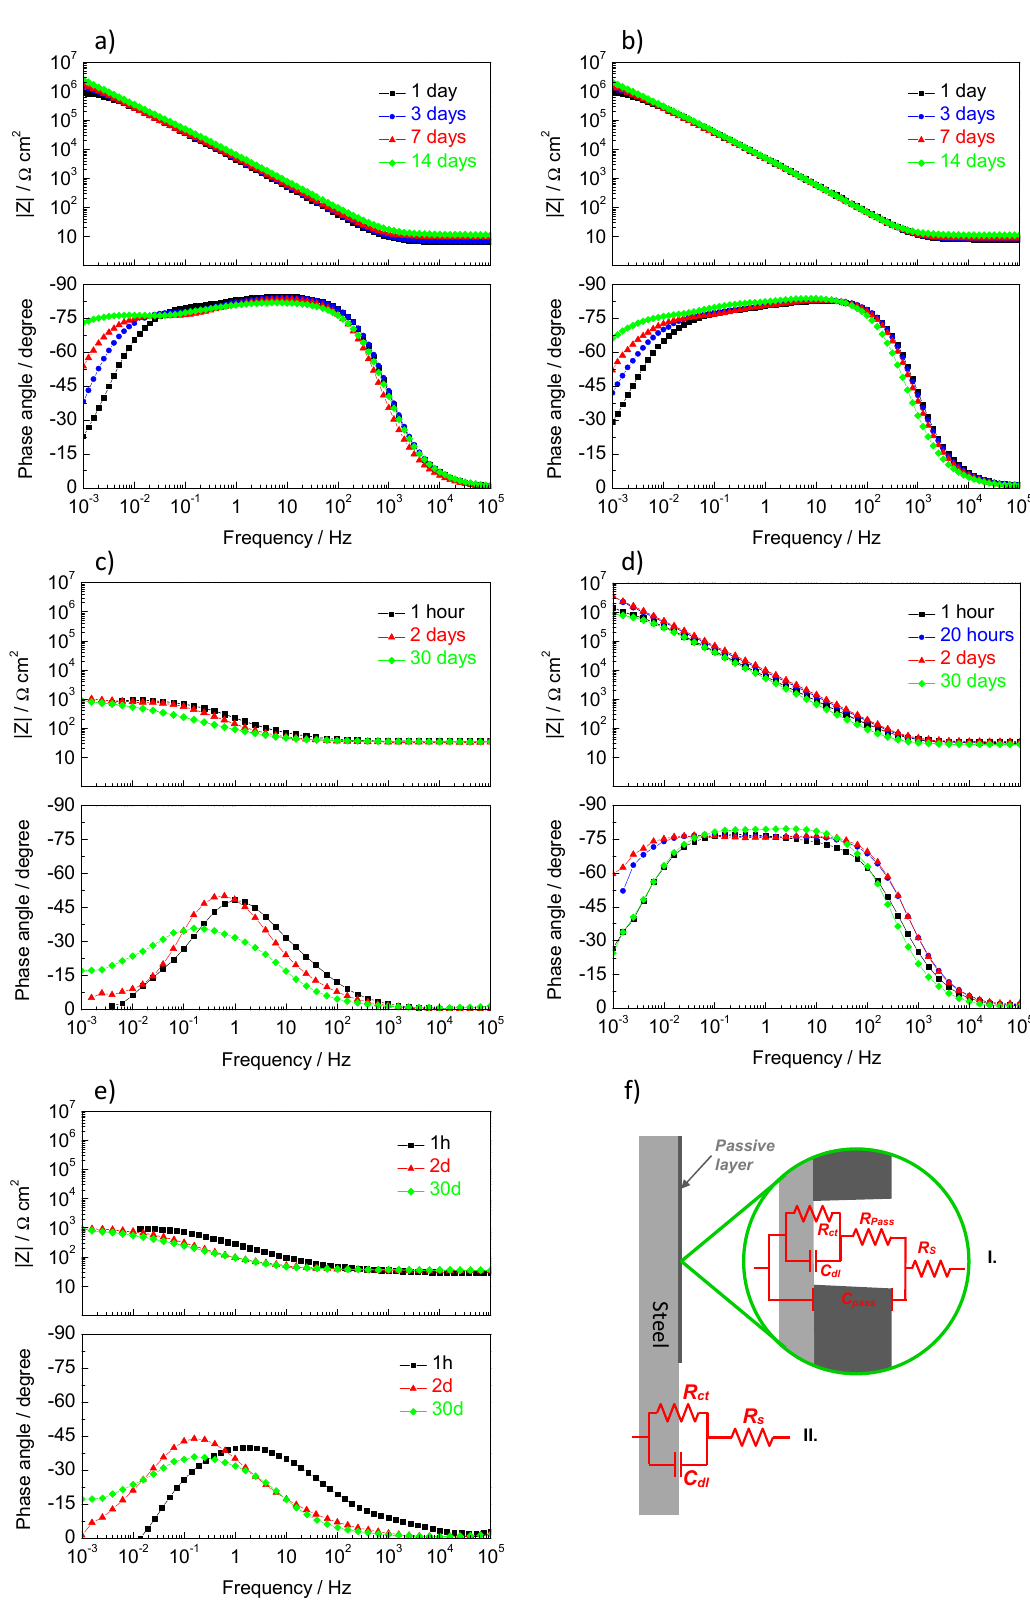
Figure 5. EIS spectra of steel obtained during immersion in ( a ) 0.05 M NaCl (pH = 13), ( b ) 0.05 M NaCl (pH = 13) + 0.5% ZnAl-NO 2 , ( c ) 0.05 M NaCl (pH~6), ( d ) 0.05 M NaCl + 0.5% ZnAl-NO 2 , ( e ) 0.05 M NaCl + 0.5% ZnAl-NO 3 , ( f ) equivalent electric circuits used for describing the impedance response.